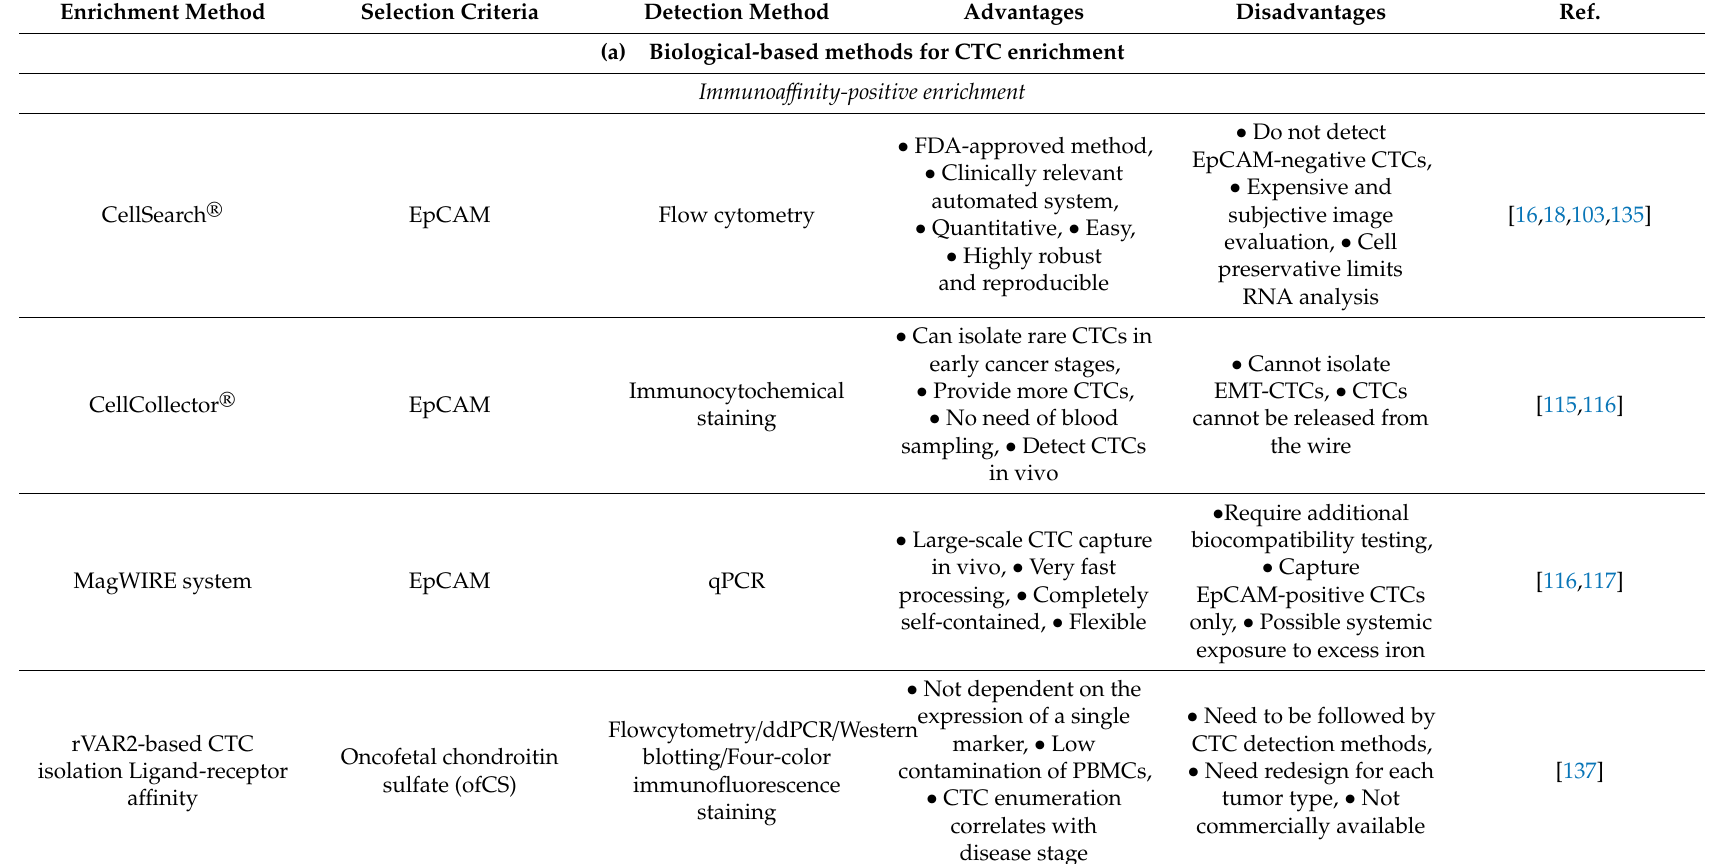
Table 1. CTC enrichment and detection based on their (a) biological and (b) physical